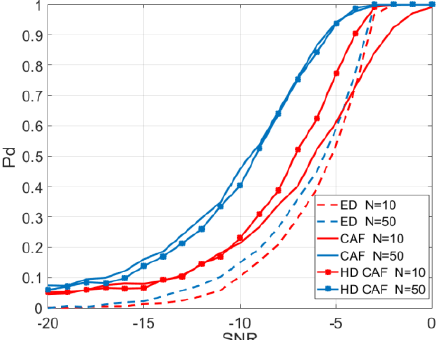
Figure 4. The probability of detection in a SNR function for HD CAV (without uncertainty of spectral density of noise power estimation influence)